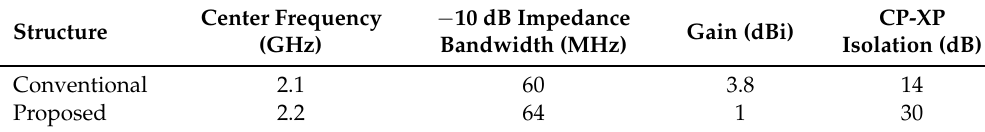
Table 1. Comparison of the conventional, and proposed antenna